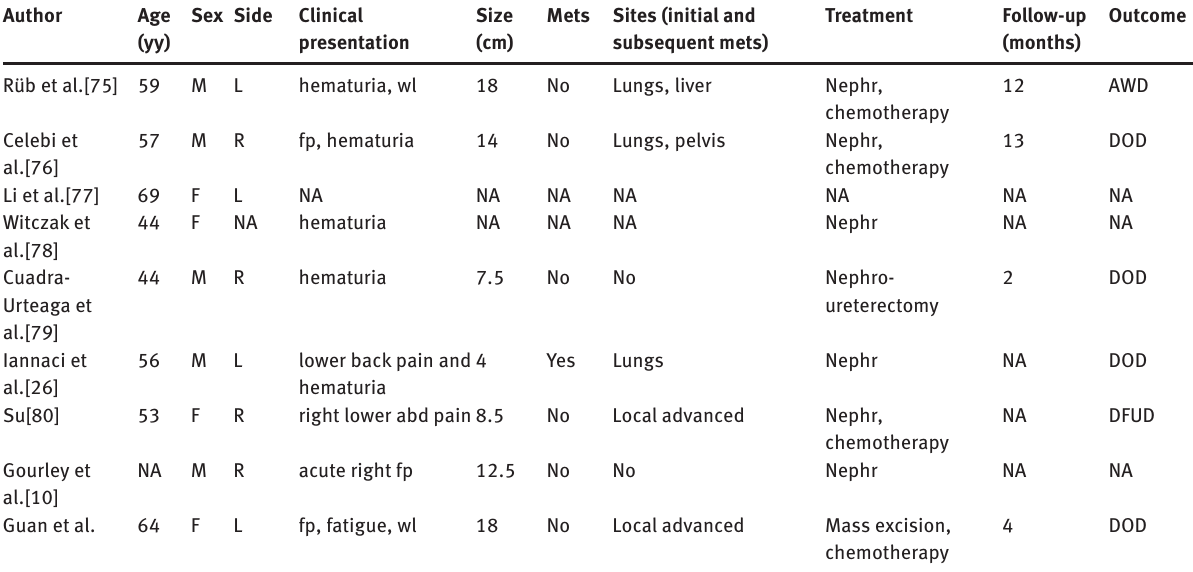
Table 1 continued: Literature review of primary kidney angiosarcoma